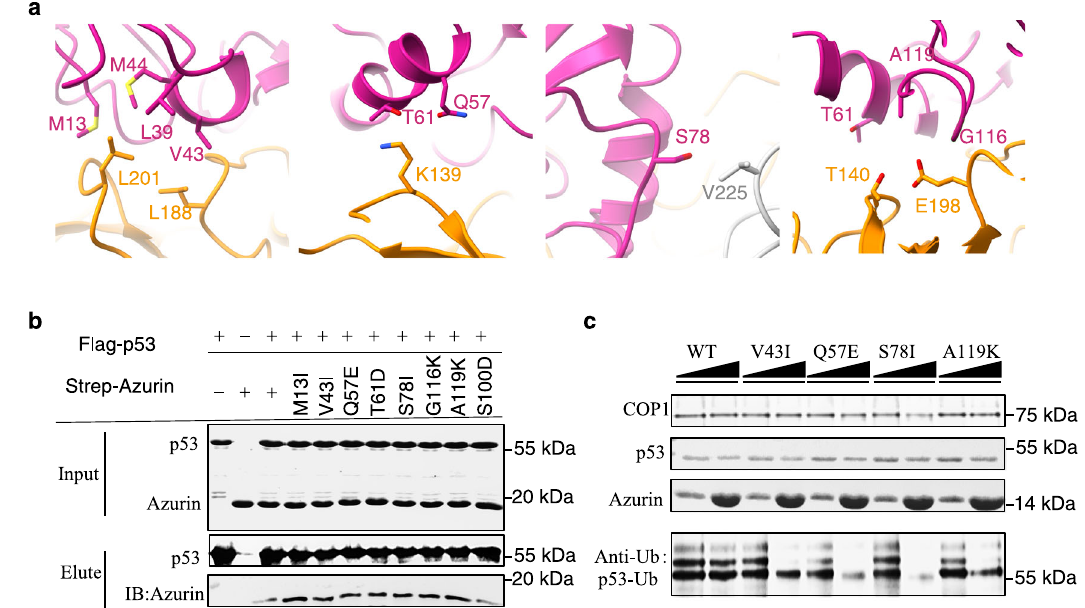
Fig. 4 Structural-guided-design of af fi nity-enhancing mutations on azurin. a Cartoon and stick rendering for residues involved in intermolecular contacts of azurin-p53 complex within a distance <4 Å. b Pull down assay validating the effect of designed af fi nity-enhancing mutations on the binding af fi nity of azurin-p53 complex. Anti- fl ag beads were used to speci fi cally binds fl ag tagged p53 to pull down strep tagged azurin or its mutants in solution. Semi- quanti fi cation of azurin or p53 in elution was measured by western-blot with anti- fl ag and anti-strep antibodies. Azurin S100 is located far away from the interface and the S100D mutation here is served as negative control. c Effect of the af fi nity-enhancing mutants on the ubiquitination level of p53. The azurin mutants are V43I, Q57E, S78I and A119K.